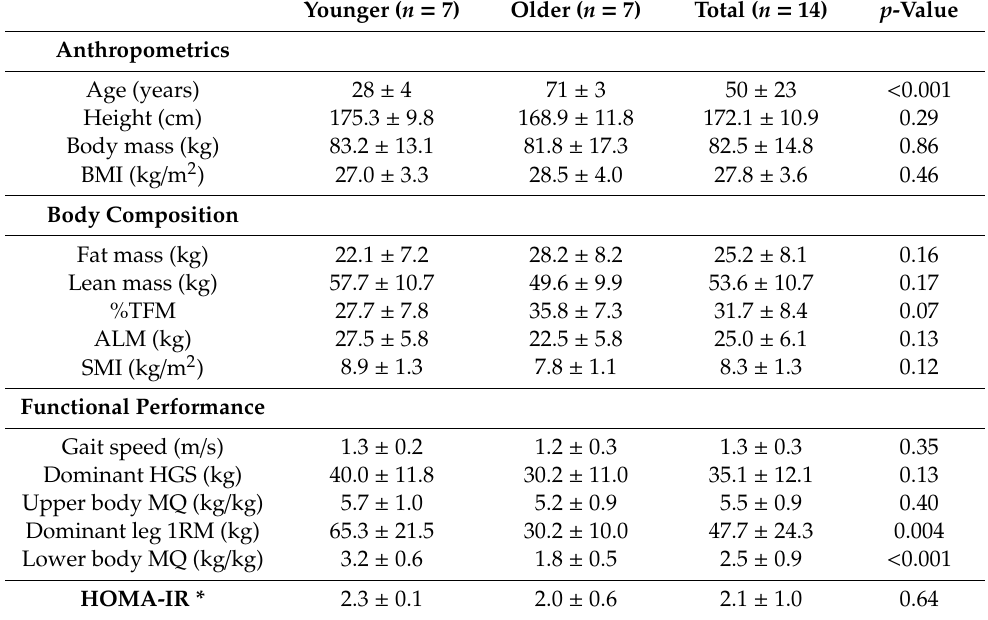
Table 1. Baseline anthropometrics, body composition, functional performance, and strength characteristics of younger and older participants (mean ±